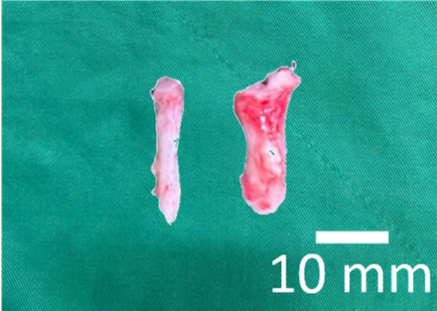
Figure 9. Tensile properties of normal tendons (maximum load-to-failure: 4.02 ± 4.74 N) and tendons repaired by the DCB – PLGA-composite nanofibers (maximum load-to-failure: 18.32 ± 2.69 N).